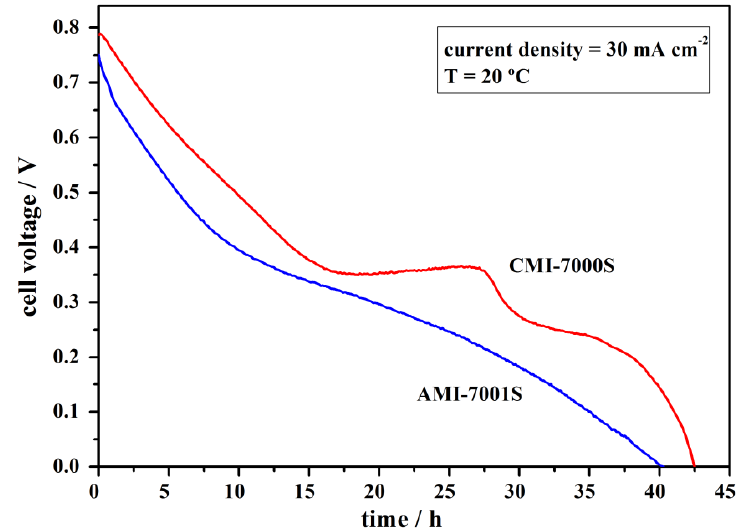
Figure 7. Full discharge of DBPFCs employing AMI-7001S and CMI-7000S membrane separators recorded at the operating current density of 30 mA·cm − 2